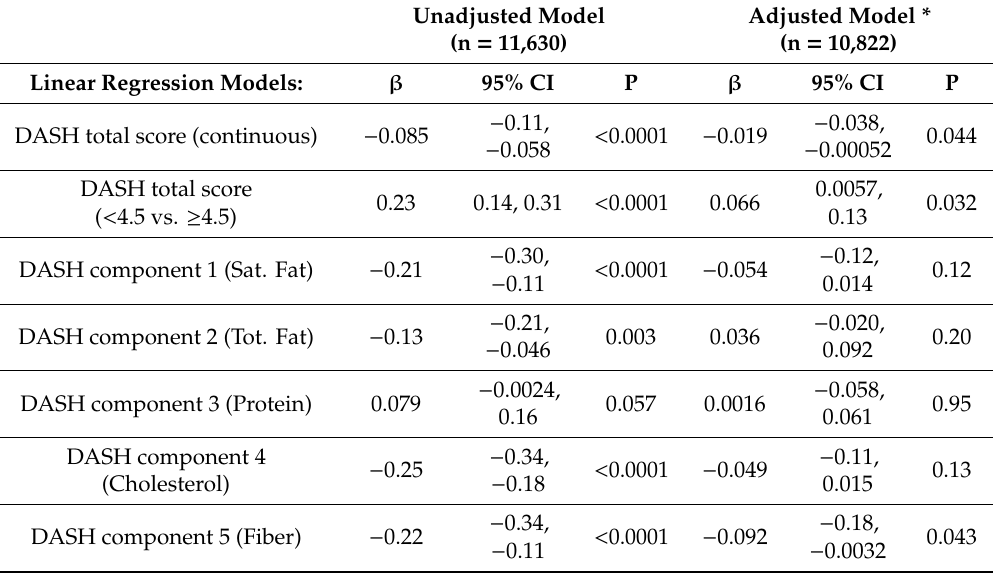
Table 4. Linear Regression Models for Dietary Approaches to Stop Hypertension Diet Score and its Component Scores as a Predictor of Allostatic Load Index Score—2001–2010 NHANES. Unadjusted Model (n =